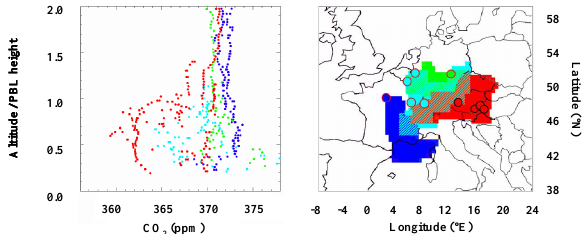
Fig. 13. CAATER 2 vertical variability analysis. Left panel: all CO 2 profiles binned over 50m layers and standardized to their re- spective PBL height. Right panel: schema of the regions covered by the backplumes associated with the profiles (profile locations are indicated by circles). Colors of right and left panels